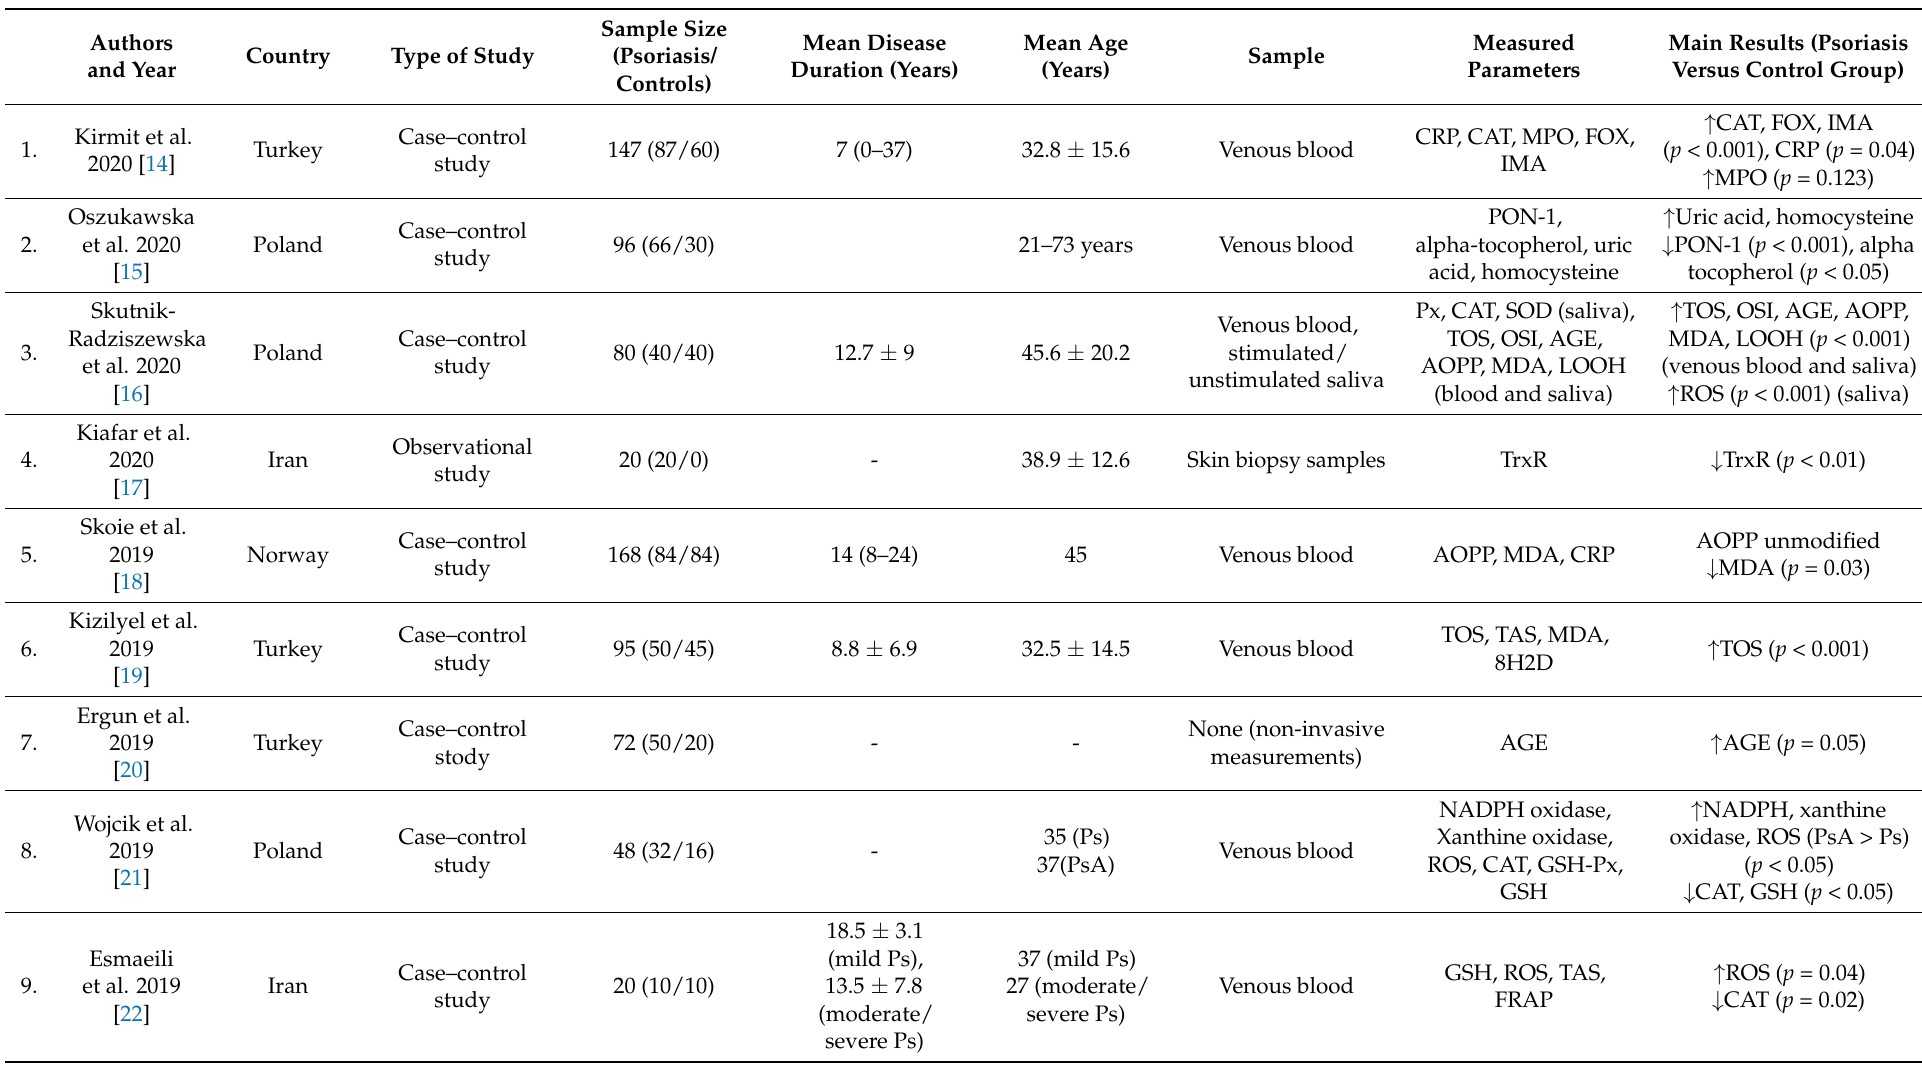
Table 1. Markers of Oxidative Stress in Patients with